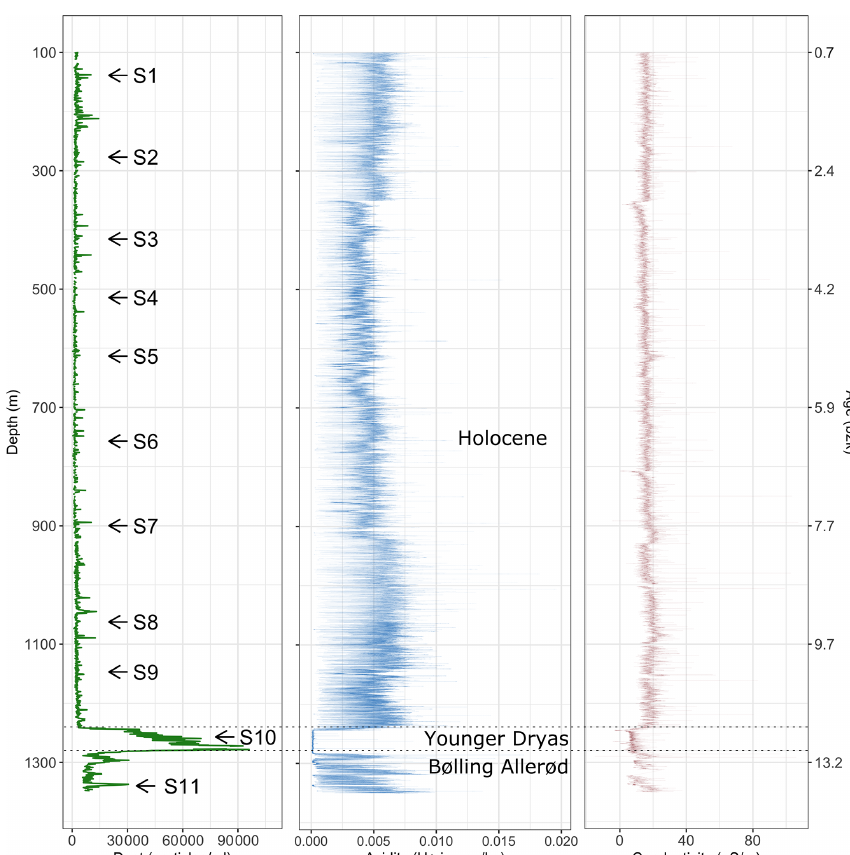
Figure 1. Number counts of particles larger than 1µmmL − 1 of melt water (dust) derived via CFA from the upper 1340m of the EGRIP ice core. Samples analysed with Raman spectroscopy are indicated with arrows. Acidity data from Mojtabavi et al. (2020b), conductivity data from Mojtabavi et al. (2020c), and age from Mojtabavi et al. (2020a) (b2k = before 2000CE in kyr).